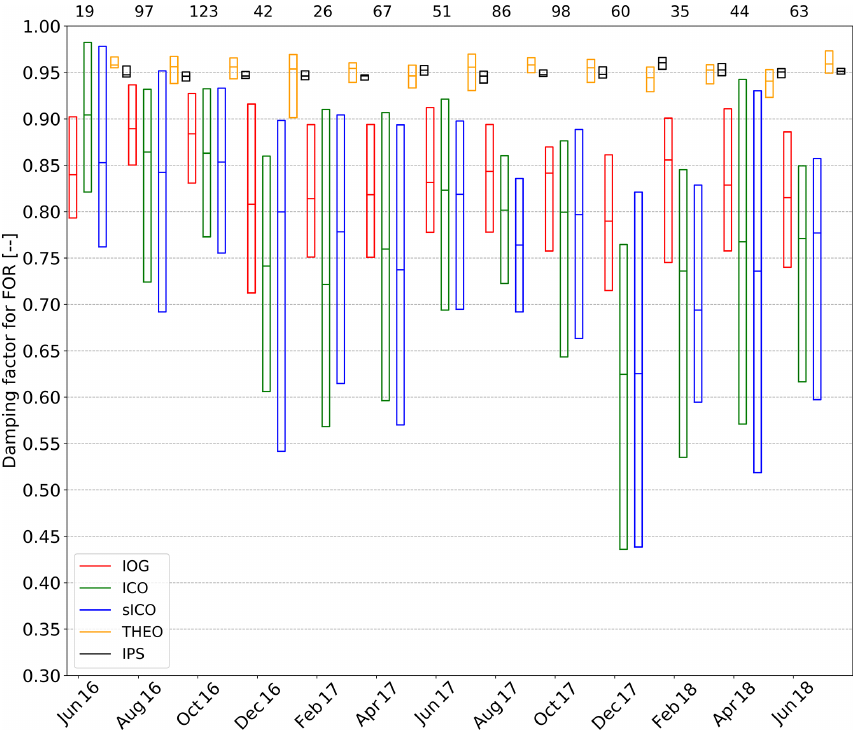
Figure 6. Box plots of the flux damping factor ( α ) for FOR without whiskers and outliers (the box frame is the 25% to 75% interquartile ranges (IQR); the bold line is the median). The number of observations displayed at the top of the plot is the same for every method.